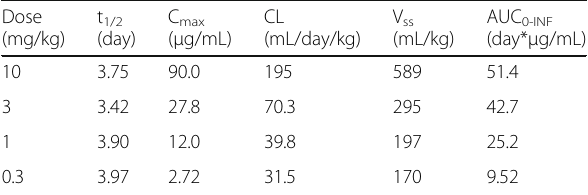
Table 1 PK parameters following IV administration of